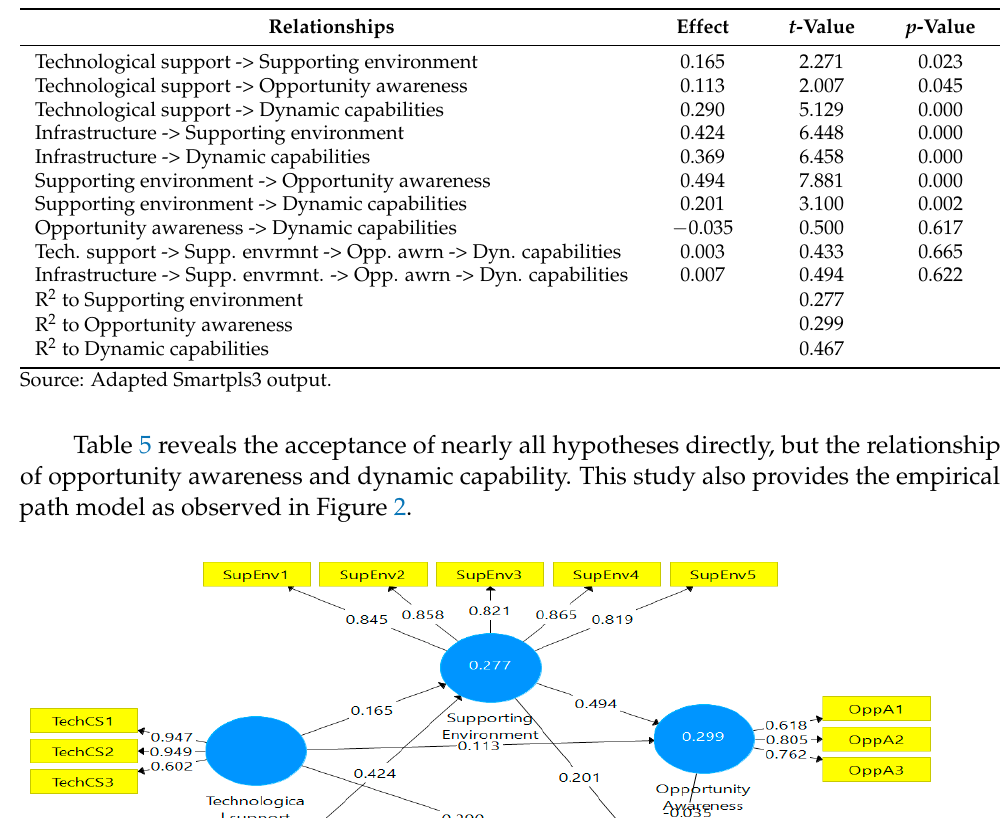
Table 5. The Summary of significance and relevance tests.